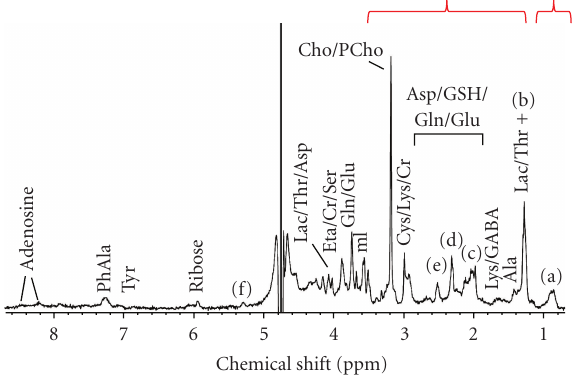
Figure 2: Typical 400MHz 1 H NMR spectra of DLKP lung carcino- ma whole cells. (a) CH 3 , (b) CH 2 , (c) CH 2 CH = CH, (d) CH 2 COO, (e) = CHCH 2 CH = , (f) HC = CH/CHOCOR. The spectral regions used for statistical analysis (0.60–1.04 and 1.24–3.56 ppm) are